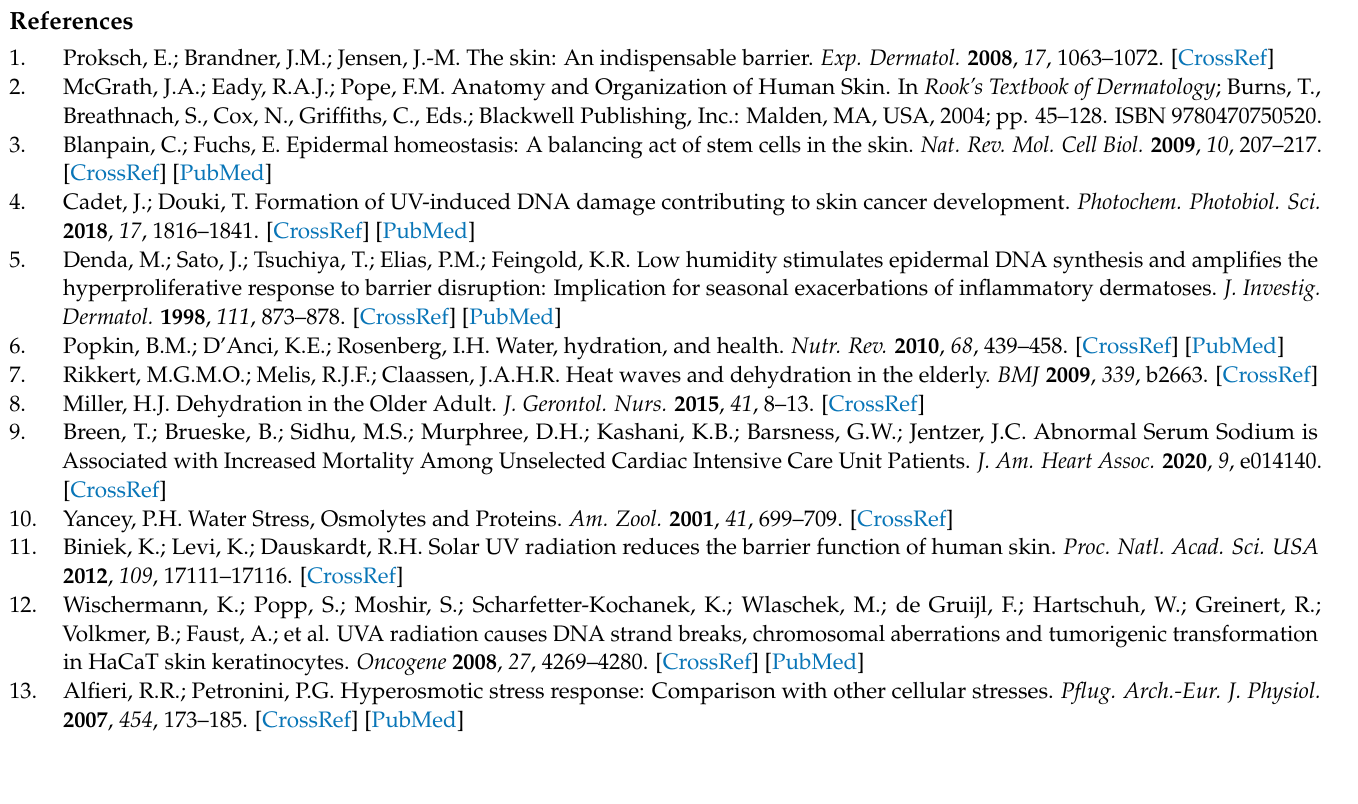
Figure S5: Percentages of γ H2AX positive cells in co-stress experiments (A) Percentages after UV radiation (n = 4) (B) percentages after H 2 O 2 treatment (n = 8). Figure S6: Cell Survival after Costress Experiments. Left side shows the treatment with UV (10 min 75 W), right side shows the treatment with H 2 O 2 (300 µ M 10 min); A, B Cells were left untreated (no NaCl, no UV/H2O2), C, D Cells are treated with UV/H2O2 with no previously NaCl treatment; E, F Cells are treated with 200 mM NaCl for 6 hours; G, H Cells are incubated with 200 mM NaCl for 6 hours and treated afterwards with UV/H2O2; I, J Cells are treated with 100 mM NaCl for 6 hours; K, L Cells are incubated with 100 mM NaCl for 6 hours and treated afterwards with UV/H 2 O 2 . Figure S7. qPCR validation of sequencing data. 2 − ( ∆∆ Ct) of the gene expression after 6 hours of 200 mM NaCl treatment (n = 3); A reduction in the expression due to treatment (2 − ( ∆∆ Ct < 1) can be seen for ATM, ATR and CCDC6, whereas PP4 is slightly upregulated with higher